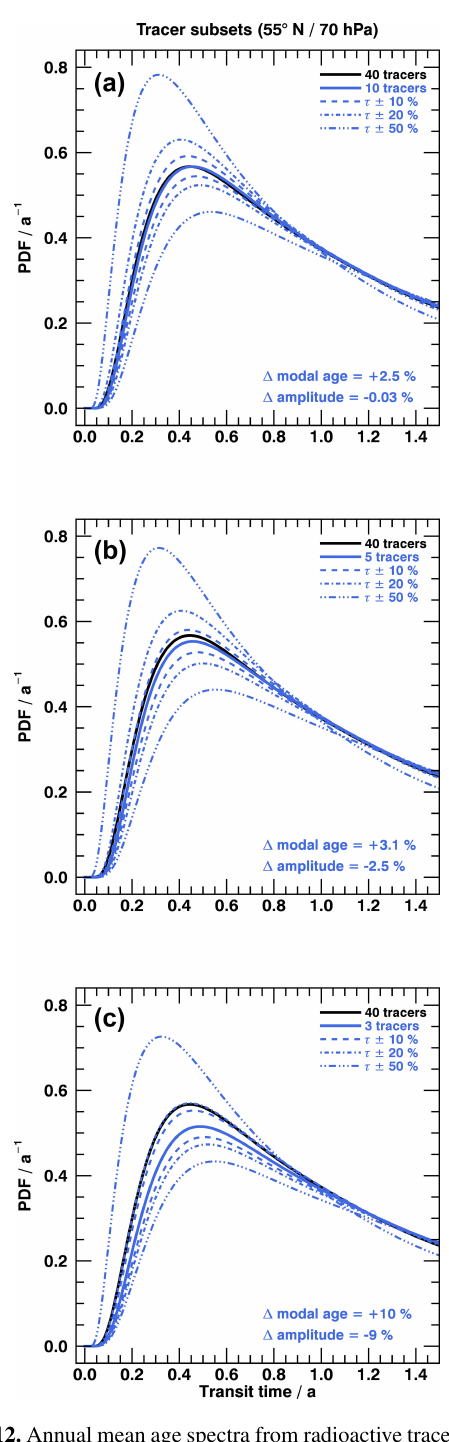
Figure 12. Annual mean age spectra from radioactive tracer subsets compared to full set at 55 ◦ N and 70hPa. The black solid line corre- sponds to the full set (40 tracers), while the solid blue line denotes spectra of a subset with 10 tracers (a) , 5 tracers (b) and 3 tracers (c) . The changes in modal age and amplitude for the solid blue lines rel- ative to the black lines are given in each panel in the bottom right corner. The three dashed and dashed–dotted spectra in each panel include an error in the knowledge of the local chemical lifetimes of ± 10%, ± 20% and ± 50% (see text for